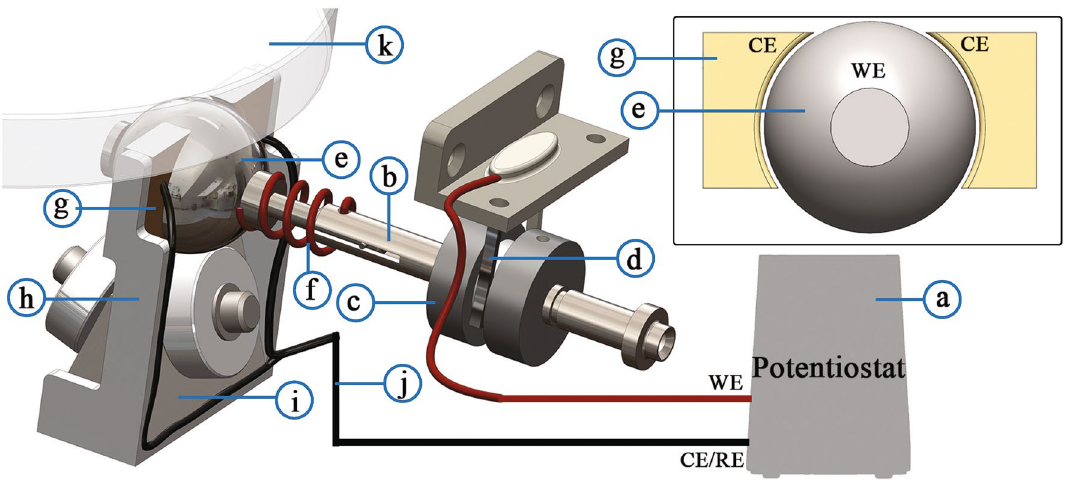
Figure 2. Schematic of modified EHD2 with a 2-electrode setup. The working electrode (WE) of the potentiostat ( a ) is connected to the ball drive shaft ( b ) through a slip ring body ( c ) and slip-ring brush ( d ). The drive shaft is further electrically connected to the ball ( e ) through a coiled wire ( f ). The drive shaft is electrically insulated form the rest of the equipment by the use of ceramic bearings (not shown). The counter electrodes (CE) for the setup are composed of two stainless steel blocks ( g ) on either side of the ball. The inner face of the blocks has a spherical face allowing a gap of approximately 0.5 mm between each CE and the ball surface (inset). These block are held in place by a frame ( h ) which is integrated into the ball carriage ( i ), which is composed of a 3-bearing geometry (ceramic bearings for electrical insulation) on which the ball rests. A strip of PTFE (not shown) electrically insulates the blocks from the frame. The blocks are connected to the potentiostat CE terminal using a set of wires ( j ). The ball carriage translates vertically to obtain the required contact load between the ball and the glass disc ( k ). (Solidworks 2019, Dassault Systèmes; available at https:// www. solid works. electrode (CE) jumped. The steel ball was the working electrode (WE). The counter electrode was composed of two stainless steel (AISI 304) blocks positioned on either side of the ball. The blocks had a spherical inner surface, allowing for an electrode gap (between WE and CE) of about 0.5 mm. The blocks were positioned on a plane perpendicular to the ball axis, allowing for the ball contact track (tribo-track) to continuously pass through the electric field created between the WE and CE during rotation. The test solution was filled till the CE blocks were submerged. A Metrohm Autolab (PGSTAT204) potentiostat was used for applying electric potential between the electrodes. During the tests, the applied potential and current across the electrodes were continuously monitored. Before each experiment, the test samples, glass disc and steel ball, were ultrasonicated in heptane and iso- propanol for 30 min each. The ball carriage was soaked in heptane and iso-propanol, successively. All the samples